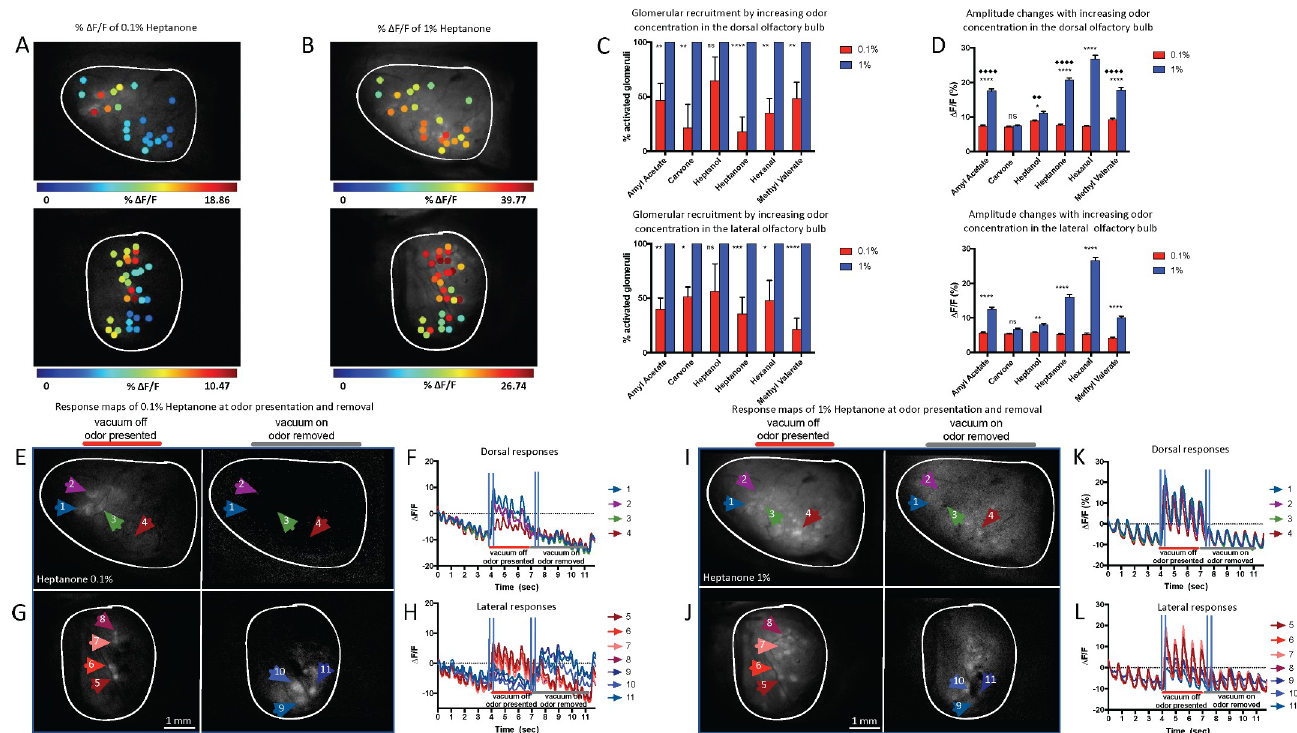
Fig 4. Glomerular odor concentration dependence. (A) Color-scaled response amplitudes for chosen ROIs for 0.1% heptanone. Top: the dorsal region of the OB. Bottom: the lateral region of the OB. (B) Color-scaled responses amplitude for chosen ROIs for 1% heptanone. Top: the dorsal region of the OB. Bottom: the lateral region of the OB. (C) Percent of glomeruli that are significantly activated by 0.1% (AA, heptanol, hexanal, and MV 5 animals; all others 6 animals) compared to the higher concentration of 1% (AA, heptanol, and hexanal 5 animals; all others 6 animals). The number of responding glomeruli to the higher odor concentration has been normalized to 100%. Top: the dorsal region of the OB. Bottom: the lateral region of the OB. Statistics represent two-way ANOVA (odor × concentration) per OB region with Bonferroni’s multiple comparisons test for concentration effect. Error bars are SEM. � P < 0.05, �� P < 0.01, ��� P < 0.001, ���� P < 0.0001. (D) Average Δ F/F responses for odors comparing 0.1% and 1% concentration. Top: the dorsal region of the OB. Bottom: the lateral region of the OB. Statistics as in panel C. Additional statistics represent two-way ANOVA (odor × OB region) with Bonferroni’s multiple comparisons test for OB region effect at 1% s.v. ♦ P < 0.05, ♦♦ P < 0.01, ♦♦♦ P < 0.001, ♦♦♦♦ P < 0.0001. (E) Odor-induced activation maps for 0.1% heptanone presentation in the dorsal region of the OB, arrows indicate 4 glomeruli. Left: during odor presentation. Right: after the odor is removed by a vacuum. Arrows indicate the same glomeruli as left. (F) Glomerular response traces for the 4 glomeruli in panel E. Vertical blue bars indicate response and reference frames to compute response maps. (G) Odor- induced activation maps for 0.1% heptanone presentation in the lateral region of the OB, arrows indicate 7 glomeruli. Left: during odor presentation. Arrows show 4 of the glomeruli. Right: after the end of odor presentation. Arrows represent 3 additional glomeruli. (H) Glomerular response traces for the 7 glomeruli in panel F. Glomeruli 5–8 (reds) respond during odor presentation, and glomeruli 9–11 respond when the odor is removed by vacuum (blues). I–L same as E–H but for 1% heptanone. Underlying data for this figure can be found in S1 Data. AA, amyl acetate; MV, metyl valerate; OB, olfactory bulb; ROI, region of